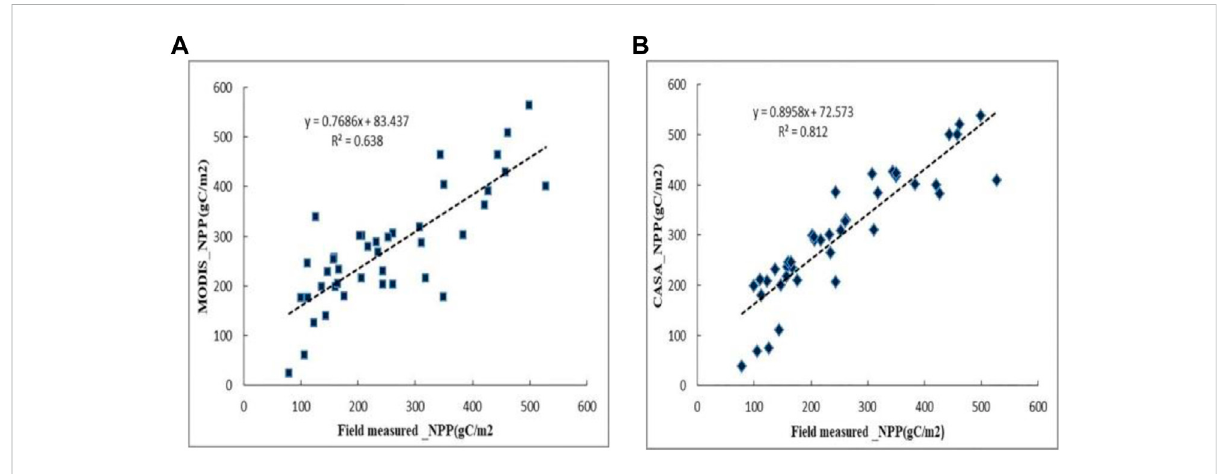
FIGURE 2 Simulation veri fi cation results of MODIS-Measured (A) , CASA-Measured (B)